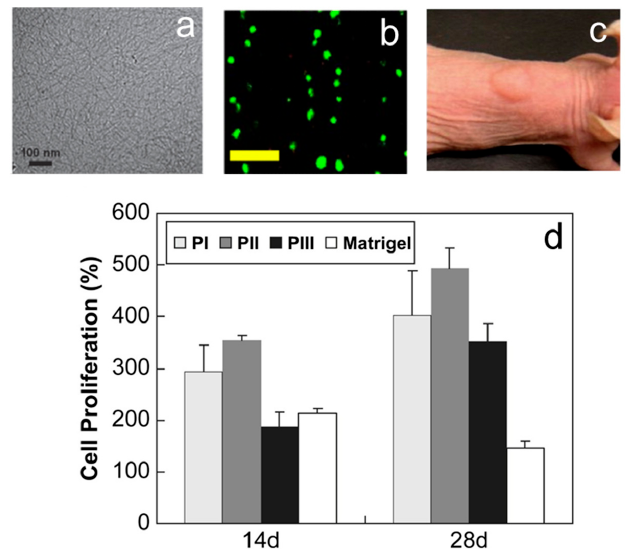
Figure 1. ( a ) Nanostructure of L/D-PA-PLX-L/D-PA. The scale = 100 nm; ( b ) Cell morphology in 28th day in L/D-PA-PLX-L/D-PA cultured systems. The scale bar is 200 μ m; ( c ) The formation of thermogels after the nude mice subcutaneous injection of the PII thermogel; ( d ) Chondrocyte proliferation rates within a thermogel 3D environment. (reproduced with permission from